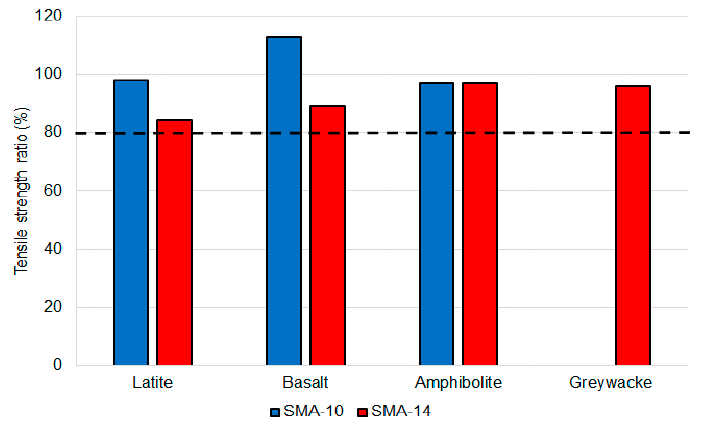
Figure 3. Moisture damage test results.